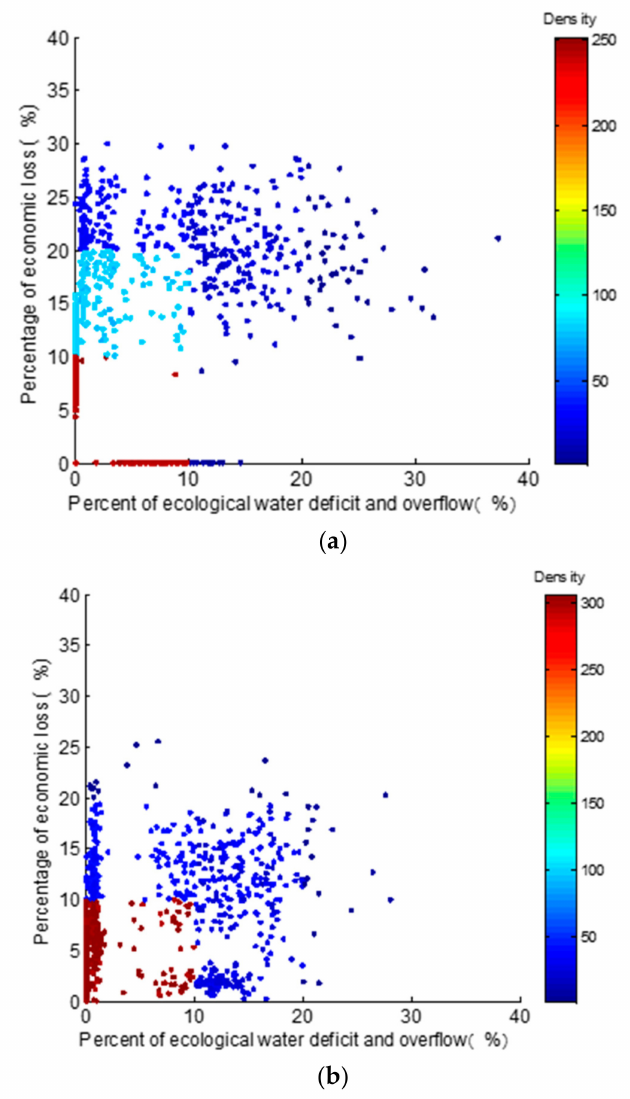
Figure 14. Distribution of reservoir operation results. ( a ) Operation results under the operation mode based on the designed guaranteed rate ( b ) Operation results under the operation mode considering